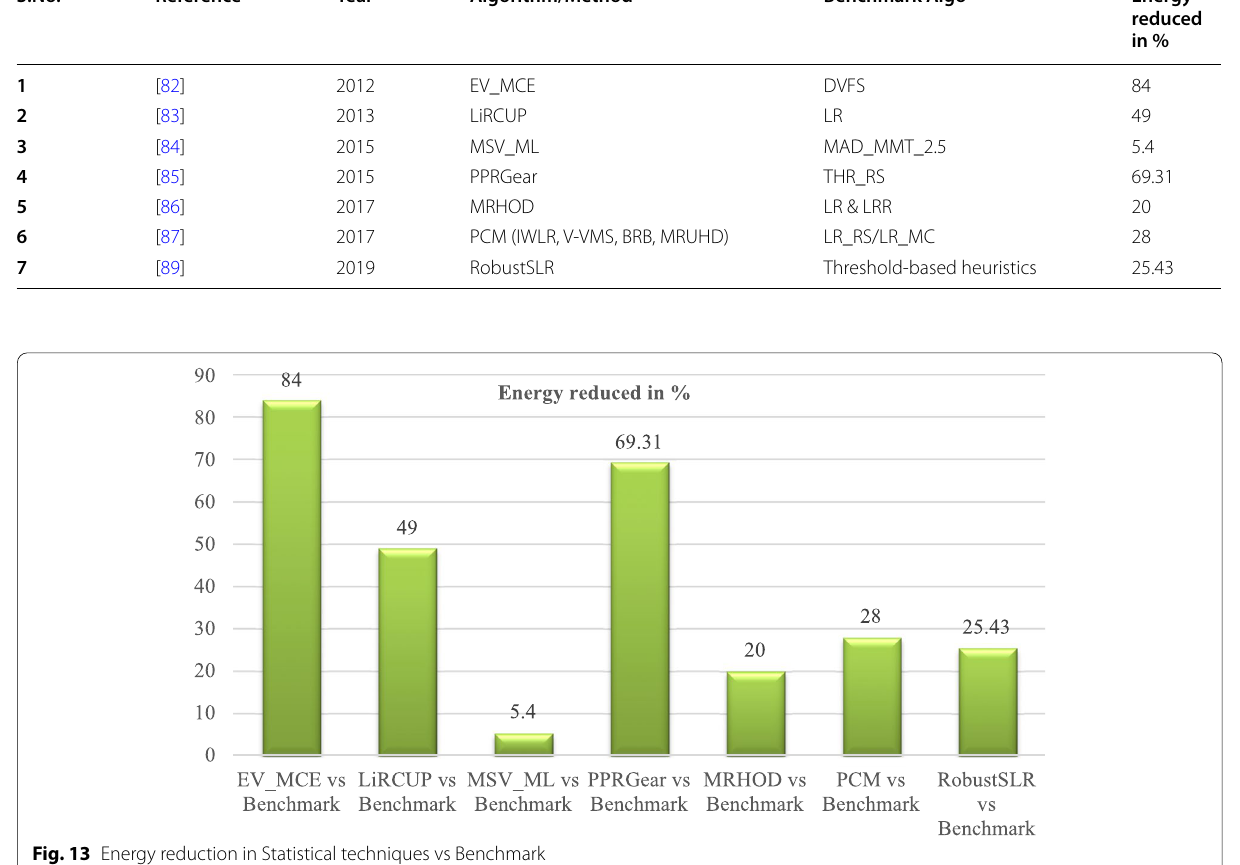
Table 8 Comparison of benchmark concerning Energy Consumption for Table 7 S.No.